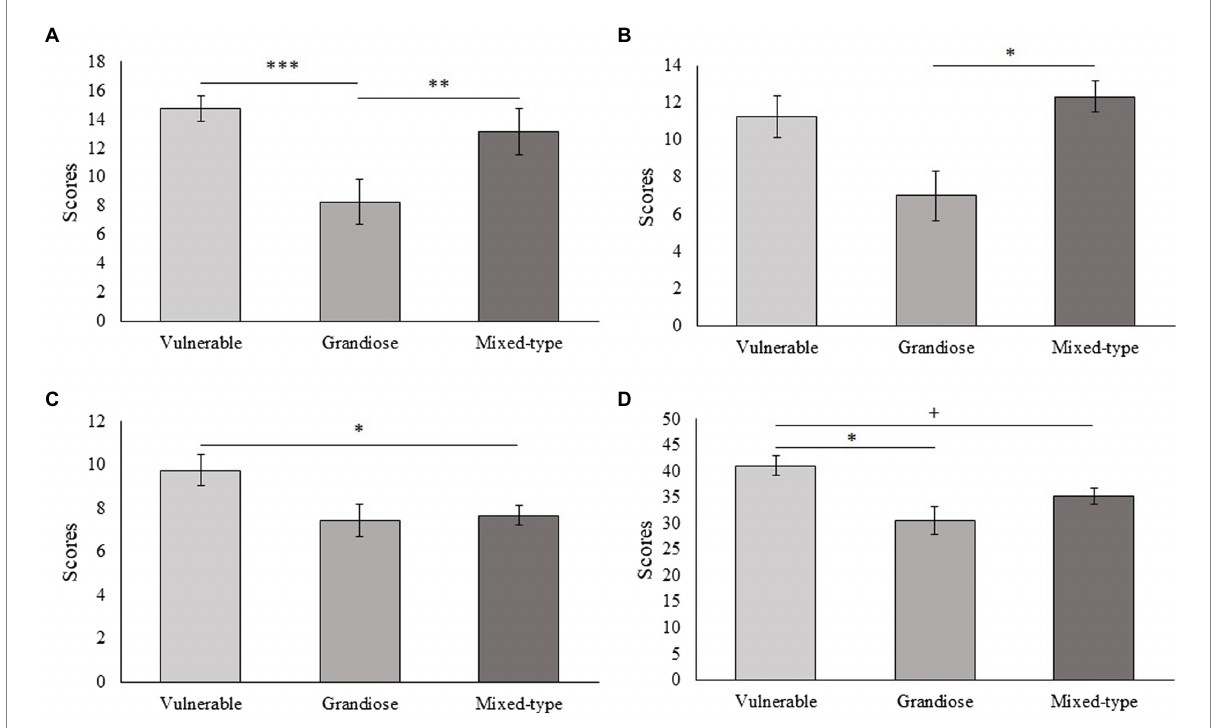
FIGURE 3 Differences between the three narcissism categories on the schizotypal traits. (A) Social anxiety [ F (2,44) = 9.259, p < 0.001, η 2 = 0.296]. (B) Eccentric behavior [ F